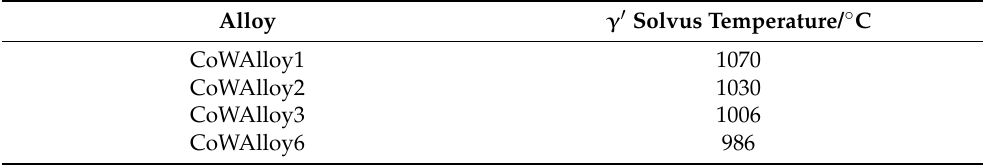
Table 3. Determined γ′ solvus temperatures of CoWAlloy1, 2, 3 and 6 [36].